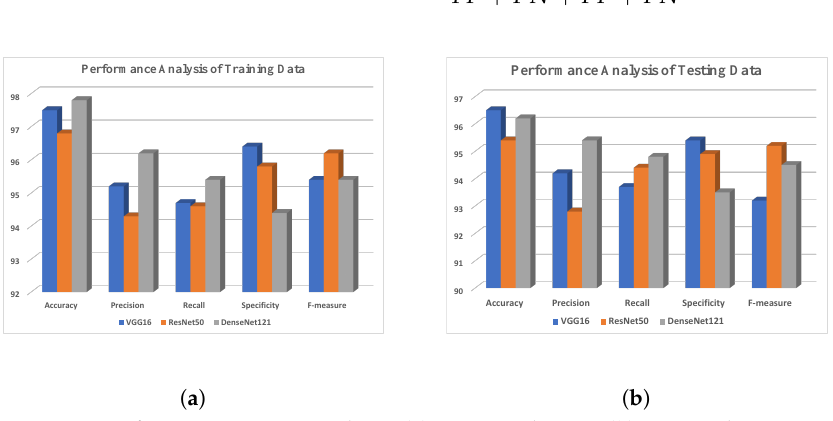
Figure 7. Performance metrics analysis. ( a ) Training dataset. ( b ) Testing